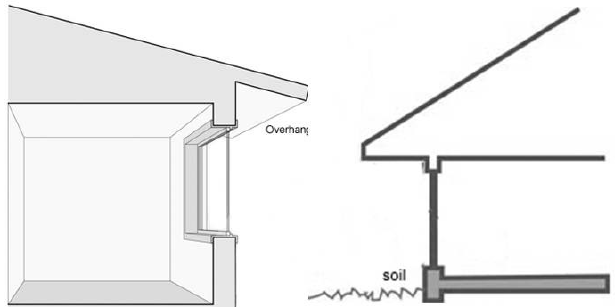
Fig 1 . Schematic of roof overhang commonly used for built structures in the